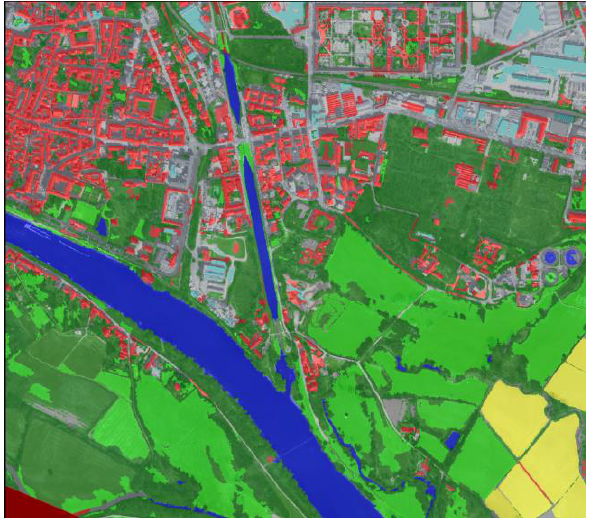
Figure 18. Final result, complete classification of the entire study area after refinement of the objects in the urban